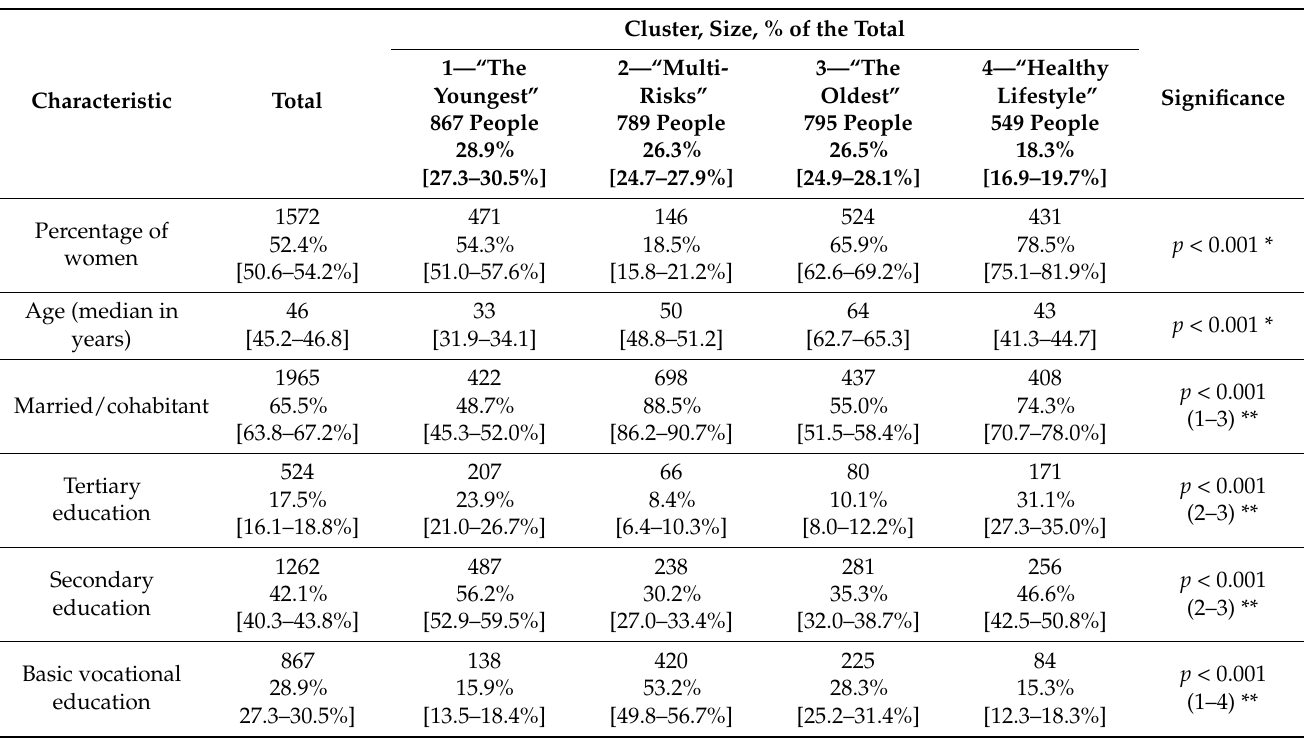
Table 1. Characteristics of the analysed population and the four distinguished clusters within the scope of features included in the clustering procedure (number and percentage of people with a particular feature for qualitative variables; the median for age; limits of 95% confidence interval in square brackets; statistical significance of differences between